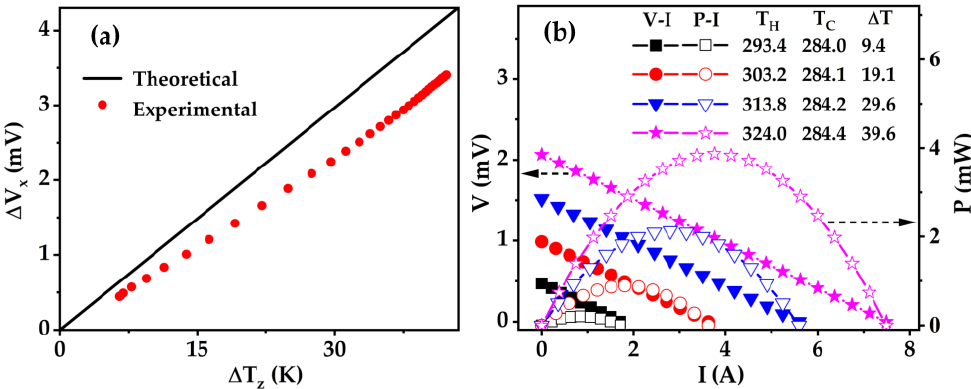
Figure 8. Power-generation performance of Fe/BTS ATMTTD: ( a ) Δ T z dependence of Δ V x ; ( b ) I dependences of V and P for Fe/BTS ATMTD.